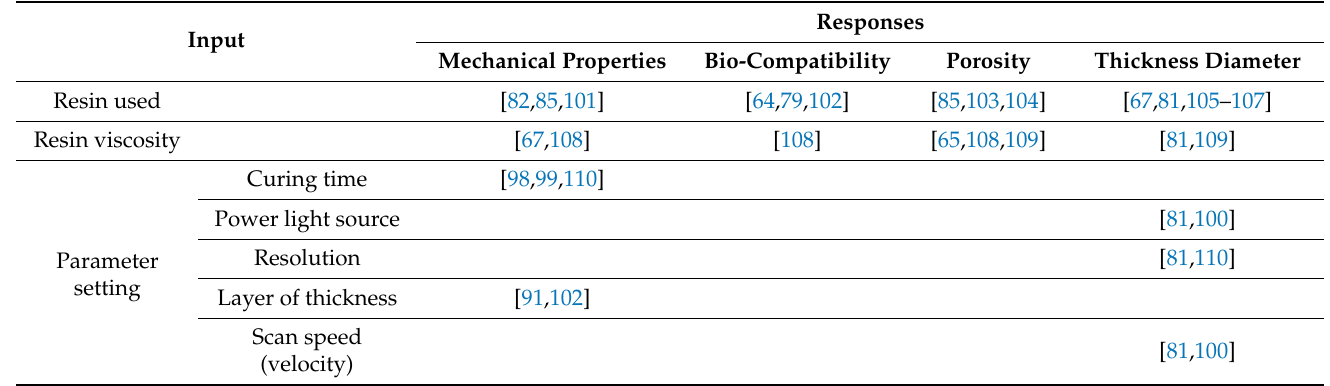
Table 4. The influences of resin selection and parameter setting for photo-polymerization 3D